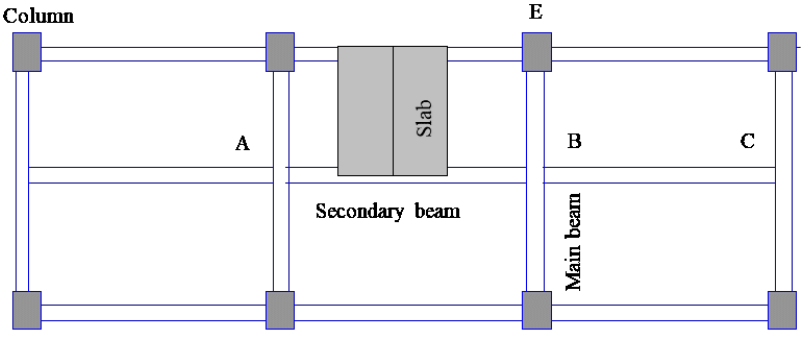
Figure 1. Indirectly loaded main beams in a plane structure.